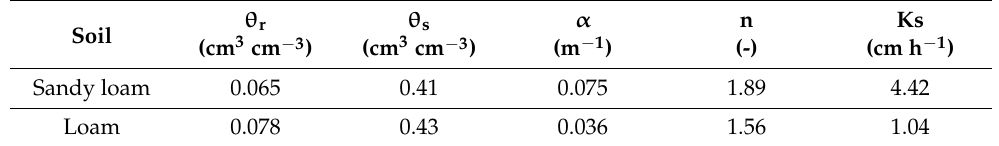
Table 2. Hydraulic properties of sandy loam and loam.